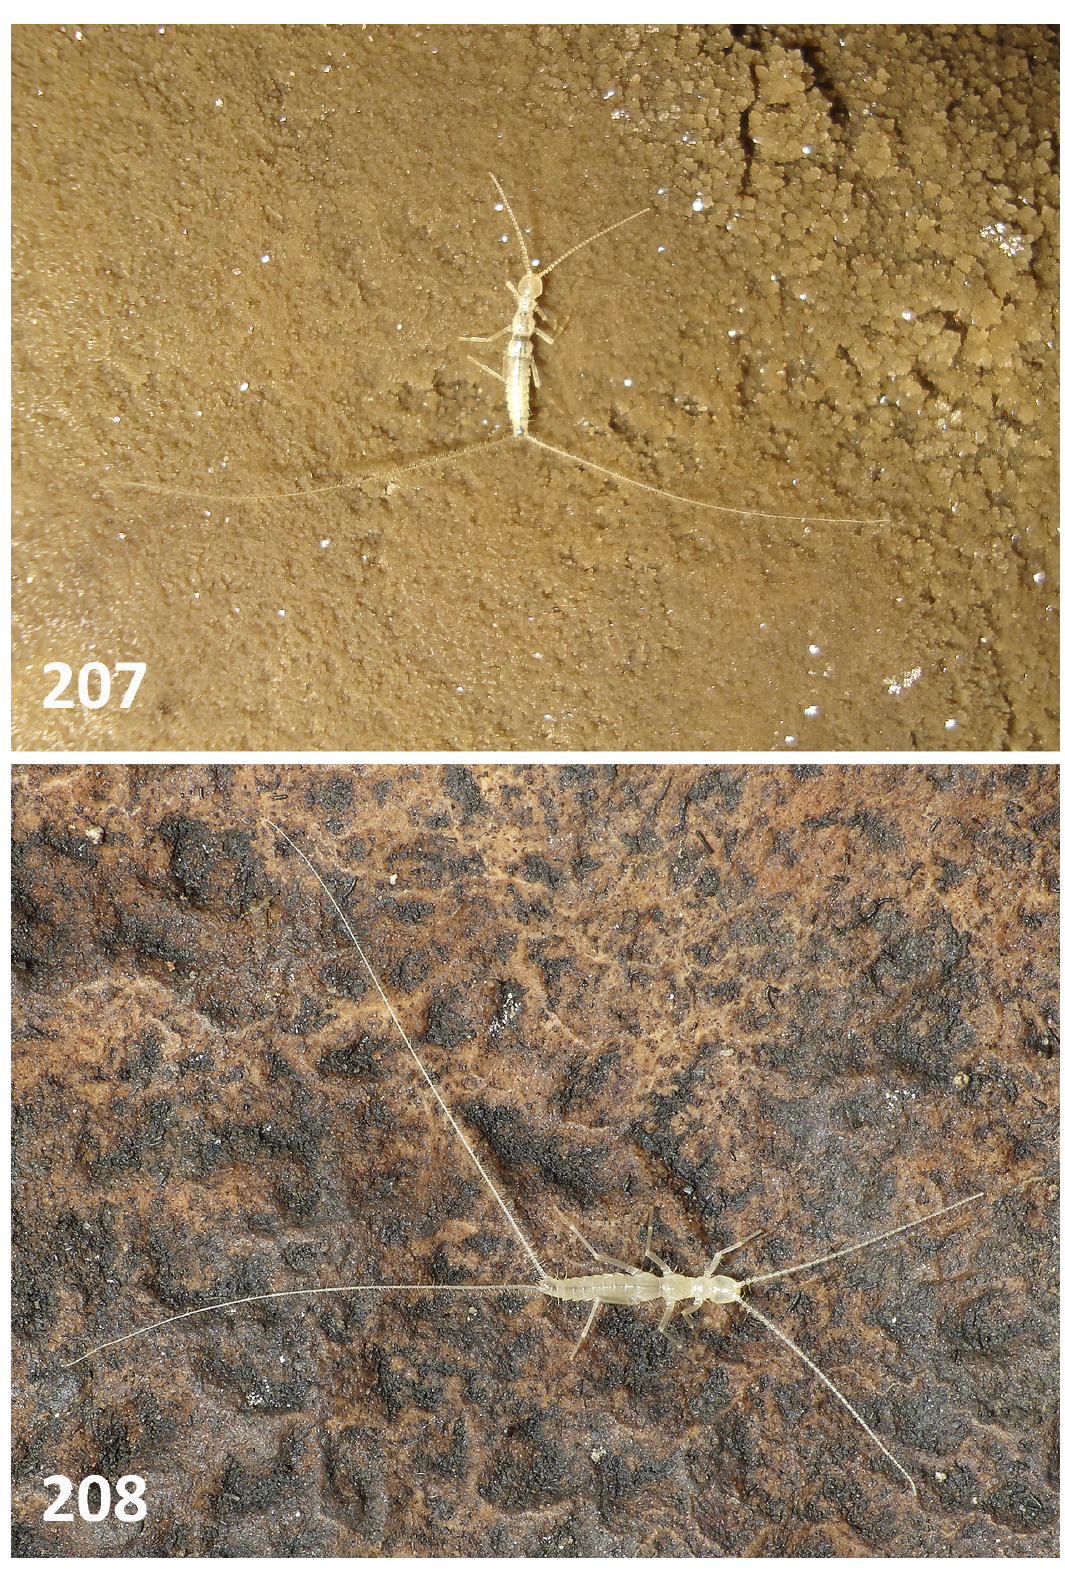
Figs 207–208. 207 . Plusiocampa ( Stygiocampa ) nivea (Joseph, 1882), from Košanski spodmol (n. 902) Obrov, Podgrad, Slovenia (photo: Fulvio Gasparo). 208 . Plusiocampa ( Stygiocampa ) dalmatica Condé, 1959, from Grotta Bac, VG 49, 400 m a.s.l., Trieste, Italy (photo: Fulvio